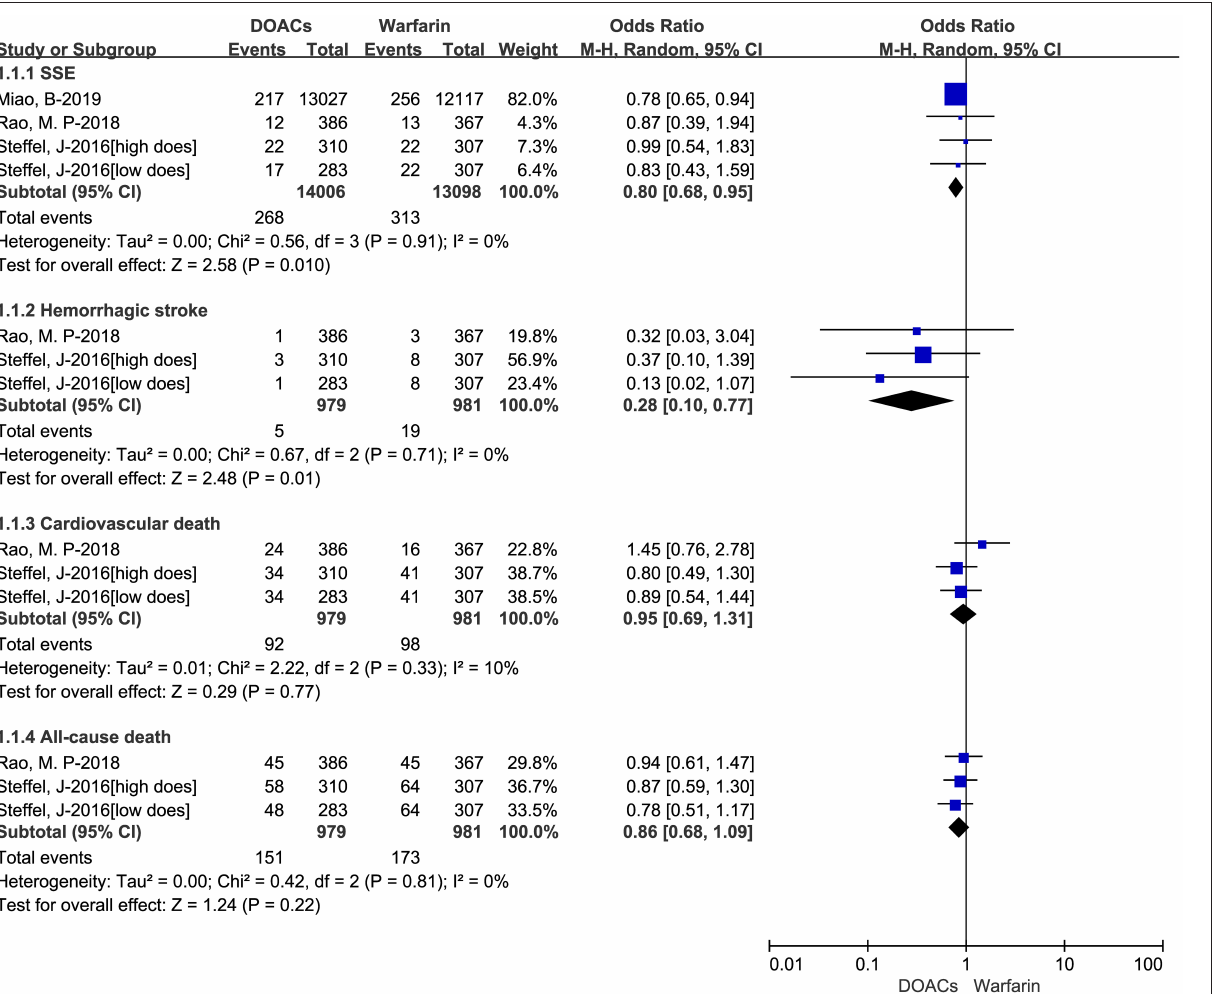
FIGURE 1 | Crude effectiveness event rates of direct oral anticoagulants compared with warfarin among atrial fibrillation patients at risk of falling. DOACs, direct oral anticoagulants; SSE, stroke or systemic embolism.